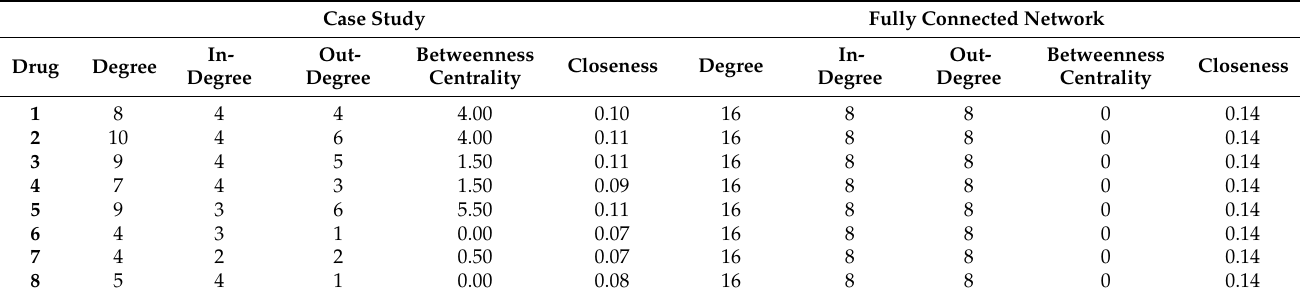
Table 2. Degree, in-degree, out-degree, betweenness centrality and closeness for each node and for the two scenarios. Case